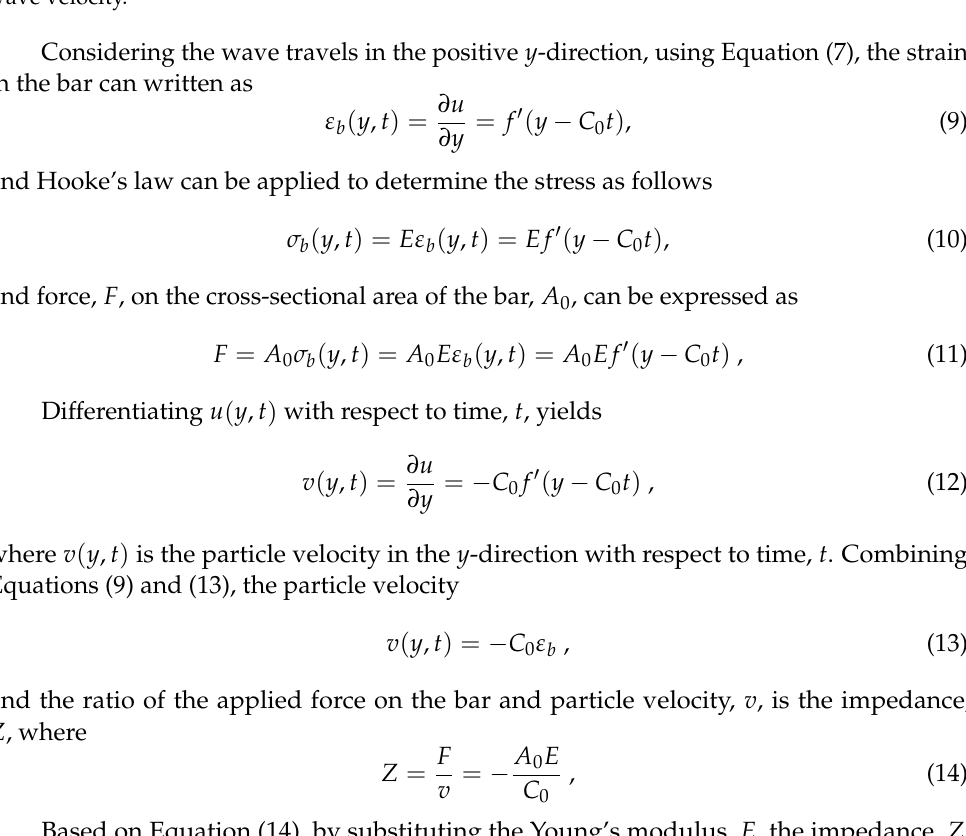
Figure 4. Wave propagation in the positive y-direction, where u is the diplacement and C 0 is the wave velocity